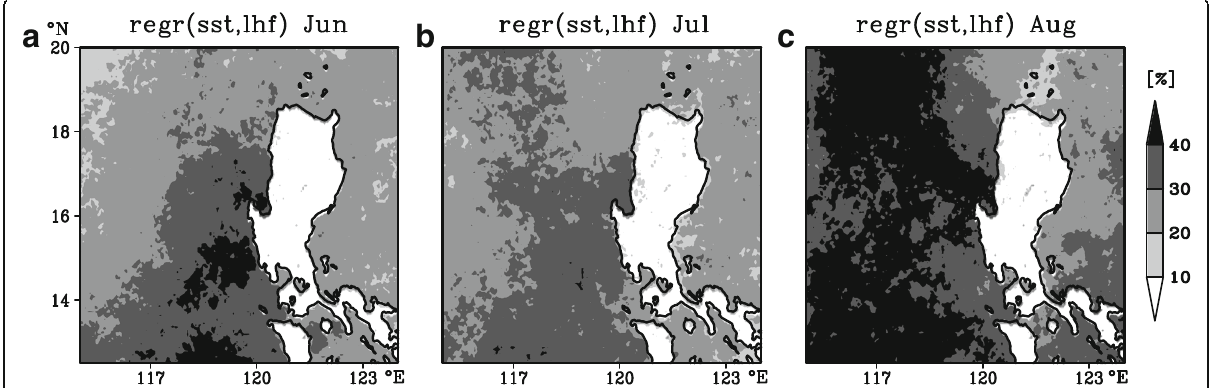
Fig. 7 Spatial map of the regression coefficients of the sensitivity of latent heat flux (lhf) to the monthly SST anomaly of the WSST reference region for 1982 – 2012 for the months of a June, b July, and c August. The values are shown in percentage relative to the 31 yr.-mean lhf from